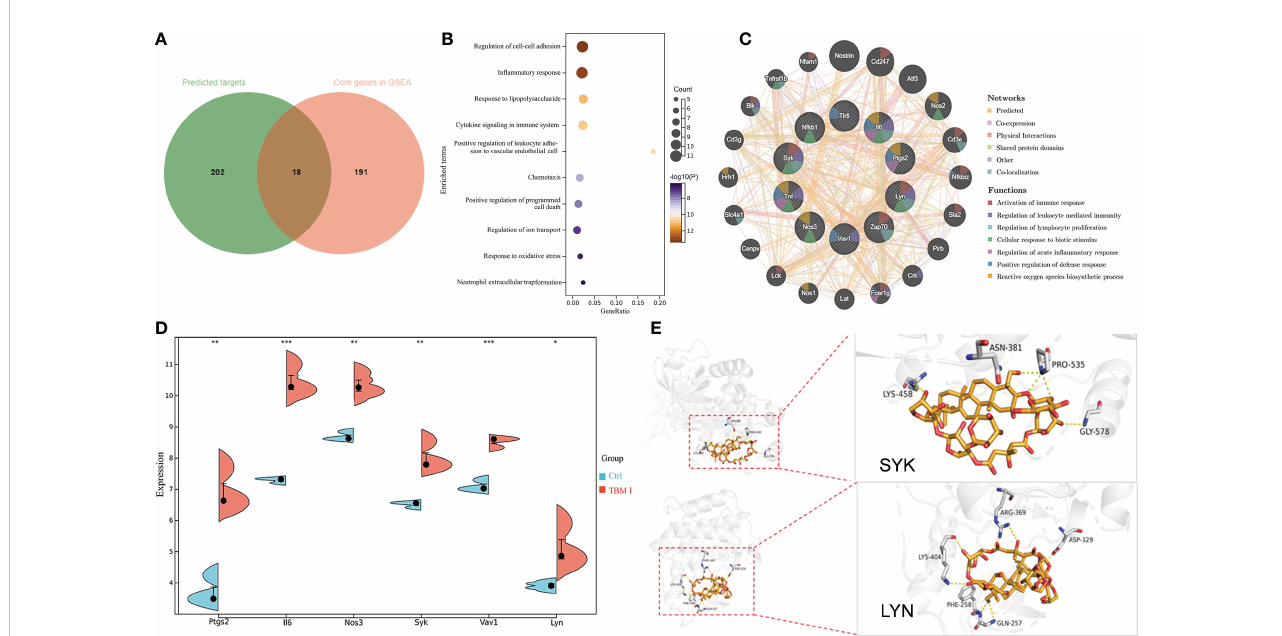
FIGURE 8 The predicted target of adjuvant activity of TBM I. (A) Overlap of therapeutic targets of TBM I (green) and core genes from GSEA of microarray data (orange). (B) Enriched terms of overlapped targets. (C) Key targets and their PPI network. (D) The expression level of key targets in microarray assay. The data are expressed as means ± SD ( n = 3). * P < 0.05, ** P < 0.01, and *** P < 0.001 vs Ctrl. (E) Binding pattern diagram of TBM I and target protein SYK or LYN. The yellow dashed line represents the hydrogen bond